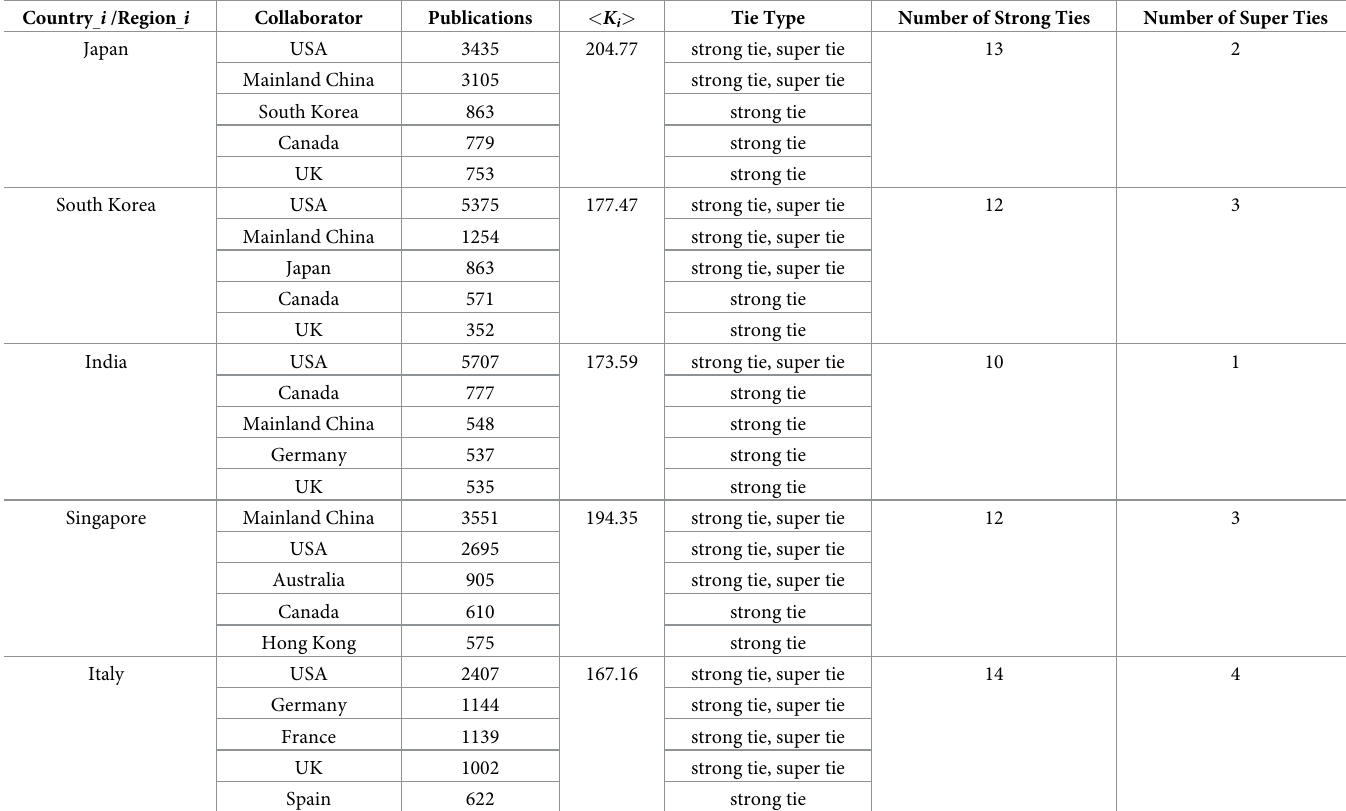
Table 3. Collaboration by low-productivity